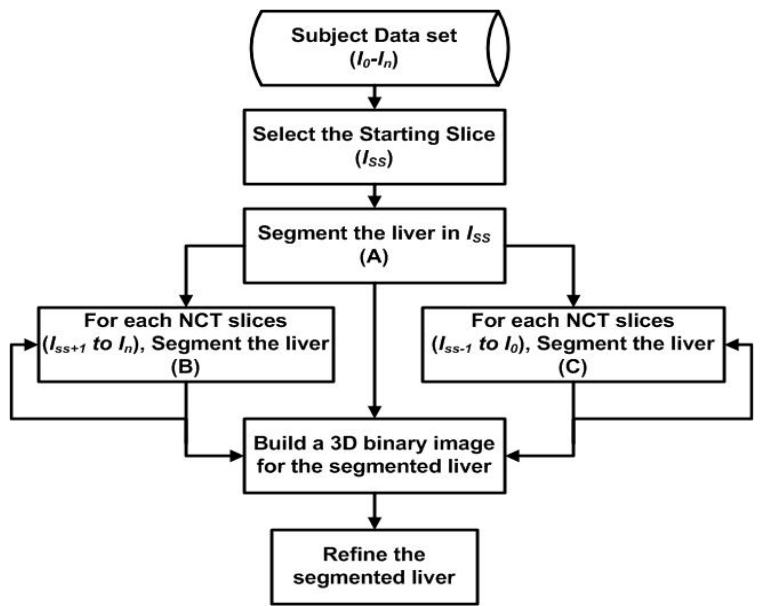
Figure 2. Block diagram of the methodology.